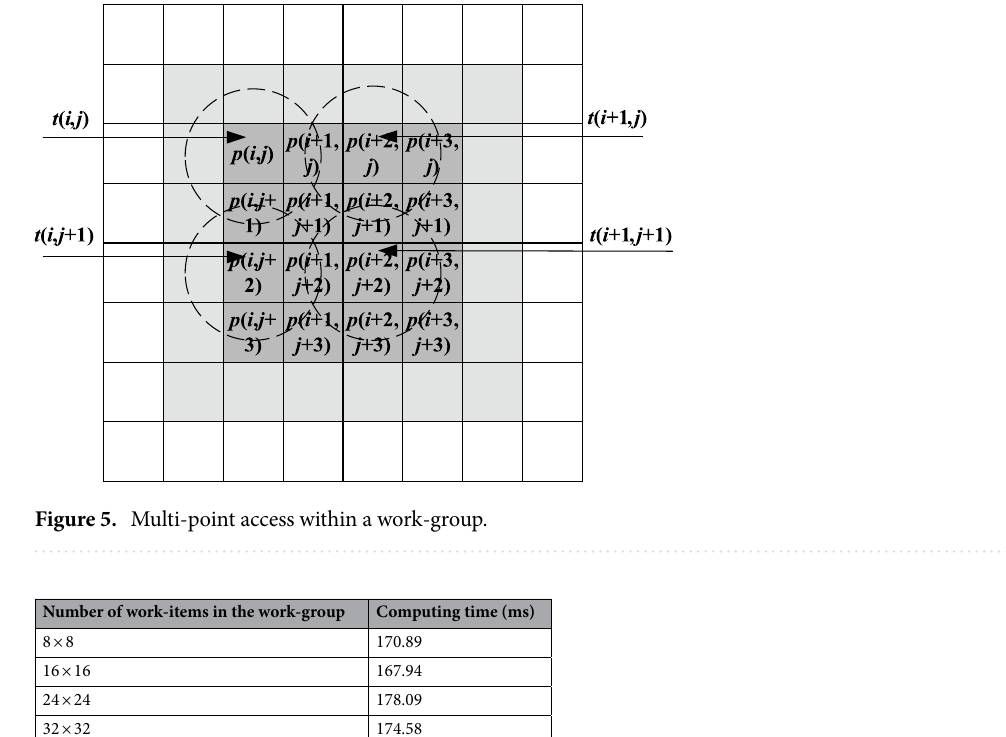
Table 2. The influence of work-group dimension on performance.